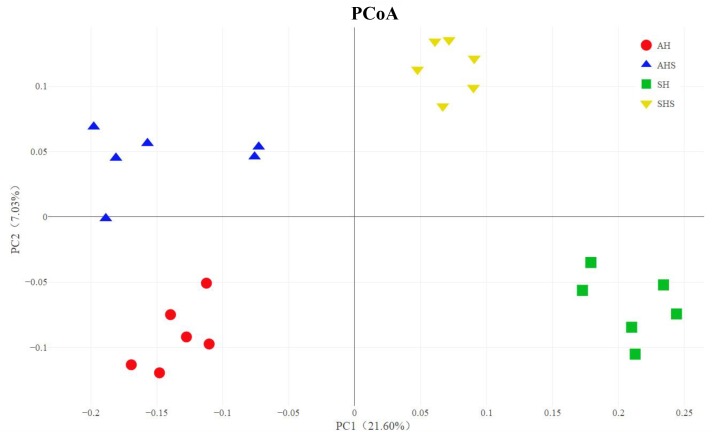
Unweighted Principal coordinates analysis (PCoA) analysis of taxonomical classifications of rumen bacterial communities in the alfalfa hay diet (AH) and saponins treated AH diet (AHS), as well as soybean hull diet (SH) and saponins treated SH diet (SHS).